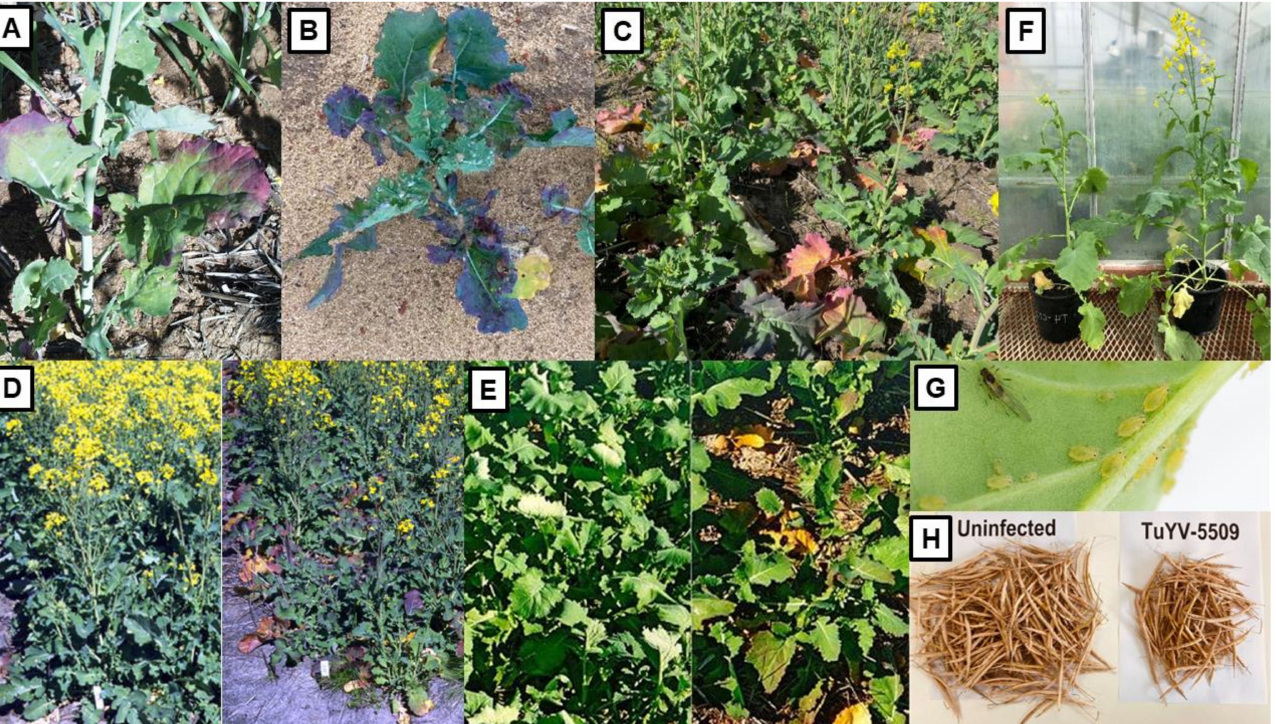
Figure 5. Turnip yellows virus infection in canola plants in Australia. ( A ) Reddening of lower leaves. ( B ) Purpling of lower and middle leaves. ( C ) Reddening, chlorosis, premature senescence and leaf drop of lower leaves. ( D ) Untreated (left) and insecticide treated (right) plots in canola yield loss field experiment: untreated plot with stunted, spindly plant growth and lower leaves with reddening and purpling, premature senescence and leaf drop versus treated plot with healthy vigorous plant growth versus. ( E ) Untreated (left) and insecticide treated (right) plots with early infection in canola yieldloss field experiment: untreated plot with young plants showing reddening, chlorosis, early senescence, and leaf drop versus treated plot with healthy young plants. ( F ) Infected (left) and uninfected (right) plants in pot experiment: infected plant with stunted growth but asymptomatic leaves versus uninfected plant with vigorous healthy growth. ( G ) Myzus persicae vector: winged adult (top left) and its wingless young offspring (right). ( H ) Seed pod harvests from individual infected (right) and uninfected (left) plants in yield loss pot experiment: pods from infected plant are smaller and contain fewer seeds. ( G ) image credit @Department of Primary Industries and Regional Development/P.